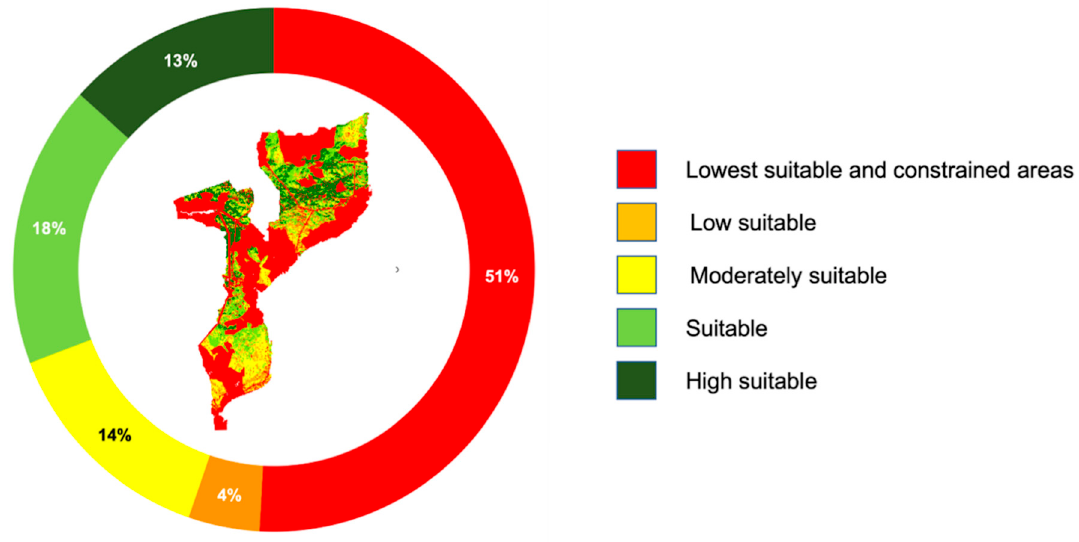
Figure 13. Boolean logic, Fuzzy logic, and AHP GIS-MCDM spatial analysis results per suitability for off-grid solar PV microgrid installation.